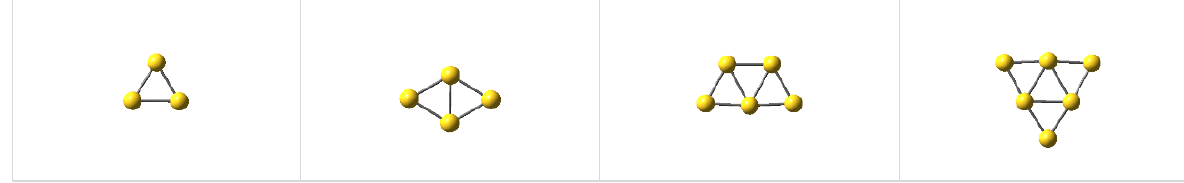
Figure 2. The calculated structures of gold clusters (Au n , n=3-6) at the DKH2-B3P86/DZP-DKH level of theory Table 1. Apex angle, symmetry and electronic state of the two Jahn-Teller components of gold trimer Apex angle Symmetry Electronic state Au 3